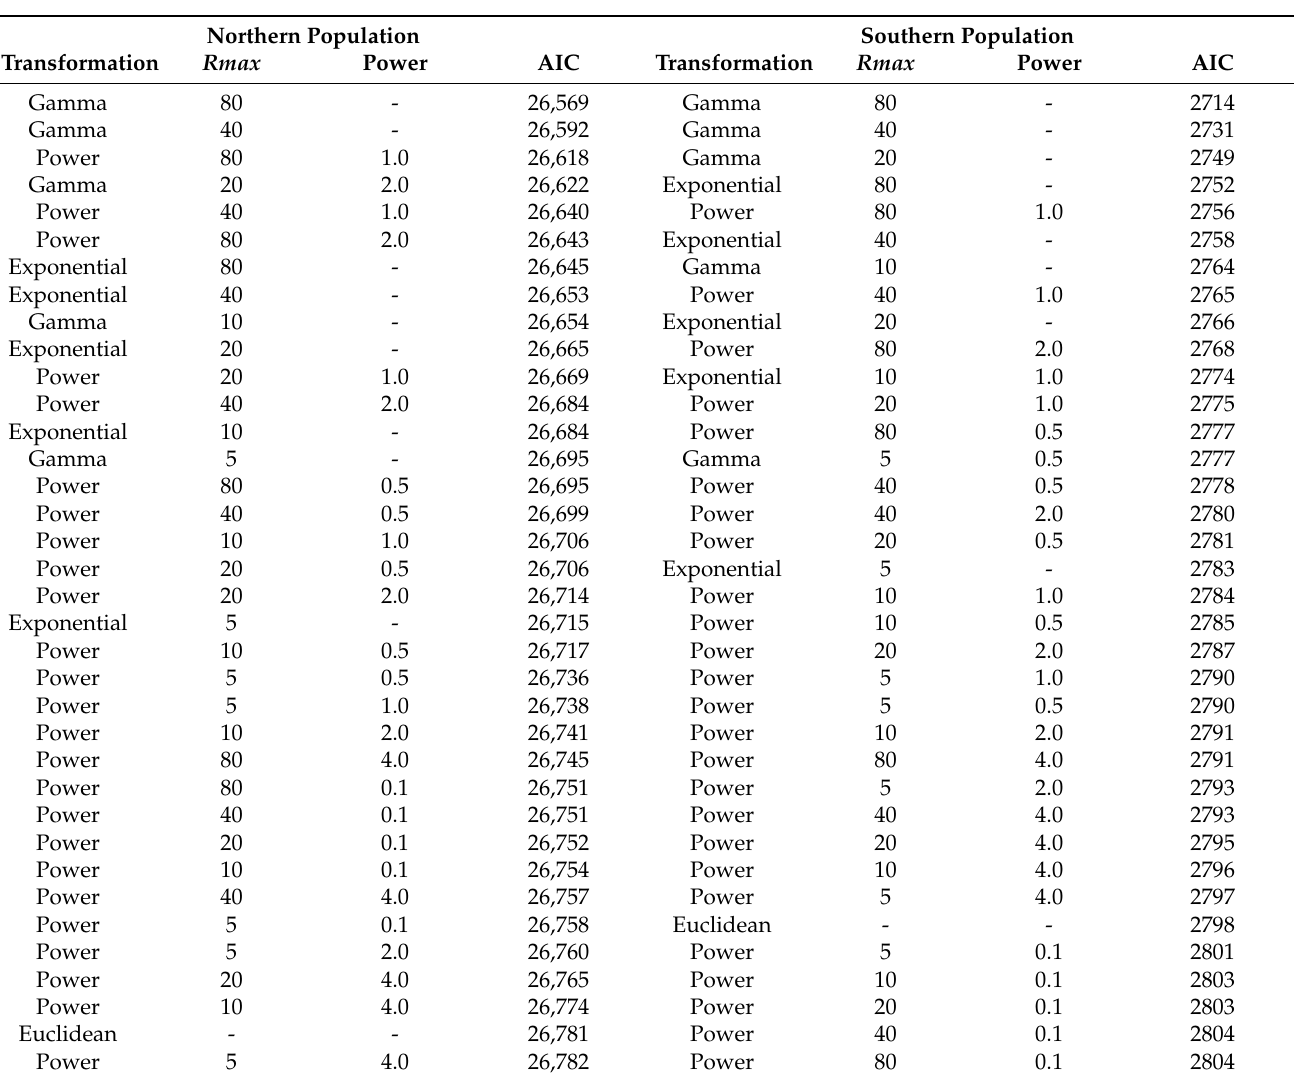
Table A2. Correlation between least-cost path landscape distance with genetic distance measured by the AIC. The resistance raster models are indicated with the transformation, maximum resistance, and power applied to the